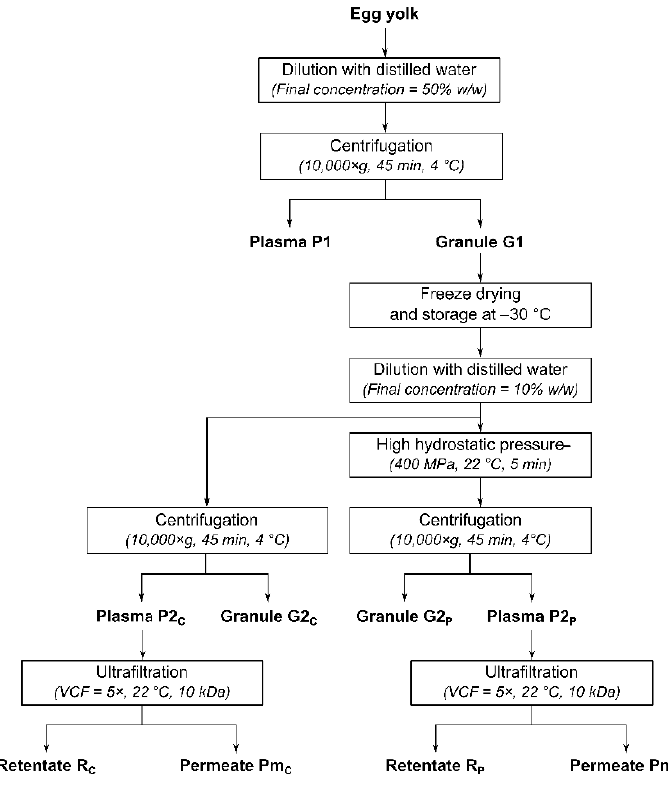
Figure 1. Experimental design for production of the different fractions resulting from high hydrostatic pressure (HHP) treatment of egg yolk granule, and concentration of the resulting plasma by ultrafiltration (UF). P1: initial plasma, G1: initial granule, G2 C : control granule, P2 C : control plasma, G2 P : pressure-treated granule, P2 P : plasma from pressure-treated granule, Pm C : control UF-permeate, R C : control UF-retentate, Pm P : UF-permeate of plasma from pressure-treated granule, R P :UF-retentate